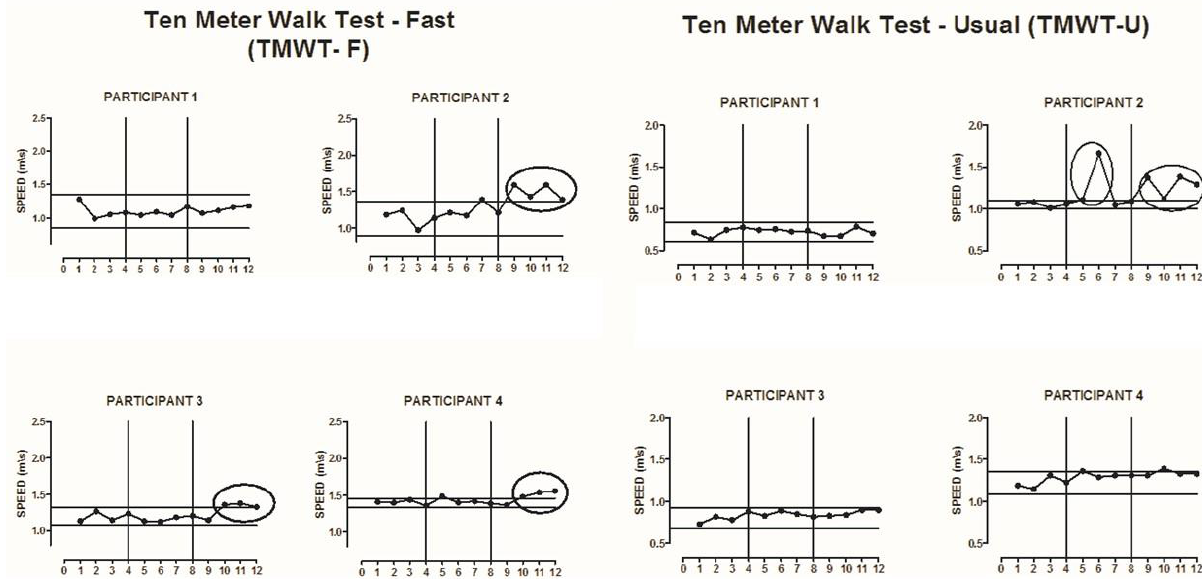
Figure 3. Visual representation of the Ten Meter Walk Test—Fast Speed (TMWT-F) and Ten Meter Walk Test—Usual Speed (TMWT-U) at baseline, intervention, and follow-up phases for participants 1, 2, 3, and 4 ( P1 – P4 ). The solid horizontal lines indicate ± 2 standard deviations from the mean of the baseline data. The x-axis represents the phases A–B-follow up, and the vertical lines divide the phases. The circles that encompass data show a change trend after a graphic visual inspection of the baseline.